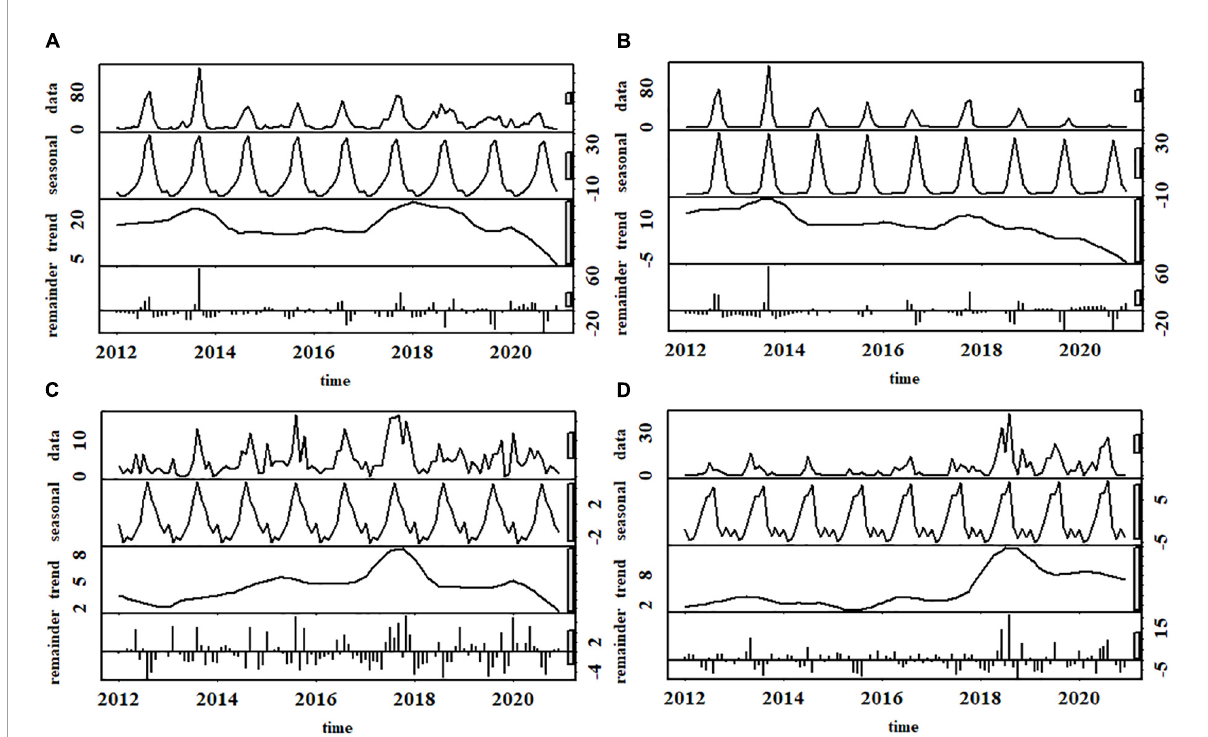
FIGURE4 Temporal patterns of human-bear conflicts showing (A) all types combined, (B) crop raiding; (C) livestock depredation, (D) beehive loss around Baoshan Section of Gaoligongshan Nature Reserve during 2012–2020.